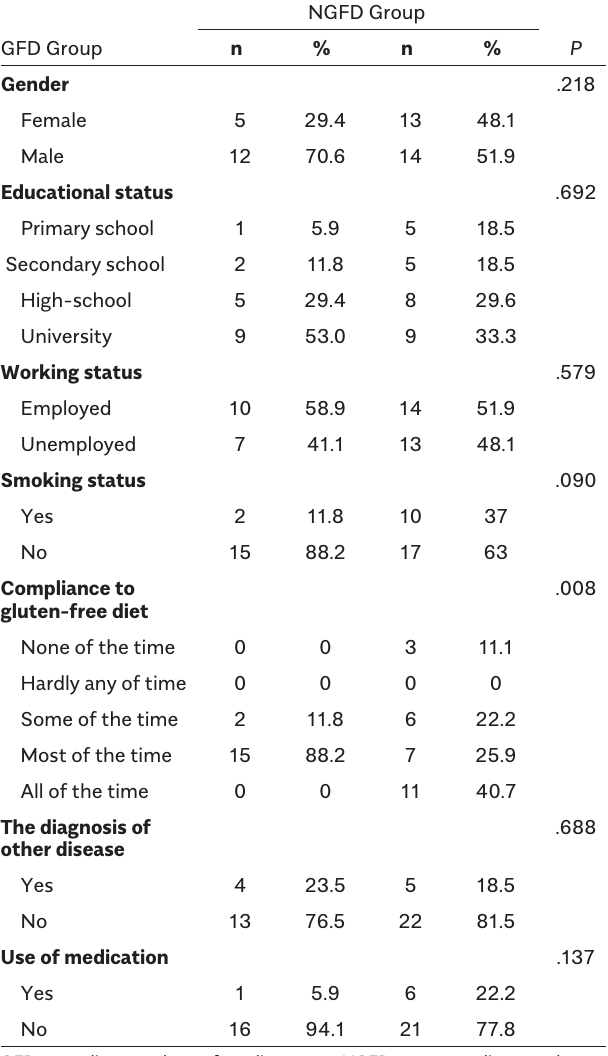
Table 2. Demographic and Clinical Characteristics